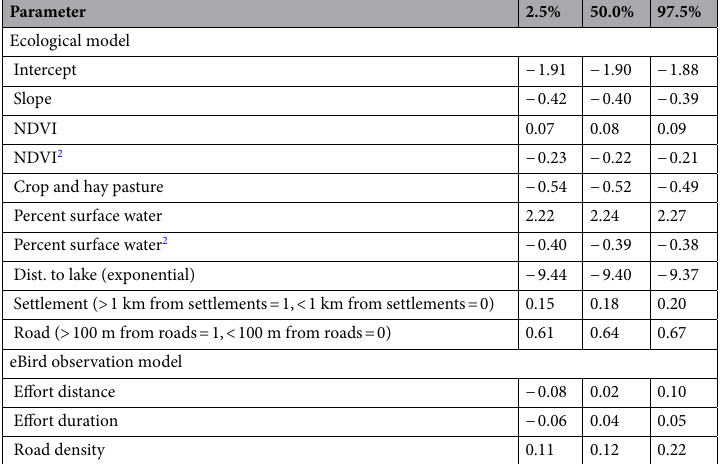
Table 2. Log-scale posterior median effect sizes and Bayesian credible intervals of a multiscale integrated point process model for breeding piping plovers. Slope and normalized difference vegetation index (NDVI) were measured at the 30 m pixel scale, crop and hay pasture were measured with a mean of neighboring pixels moving window analysis, and percent surface water was measured with a mean of 90 m moving window